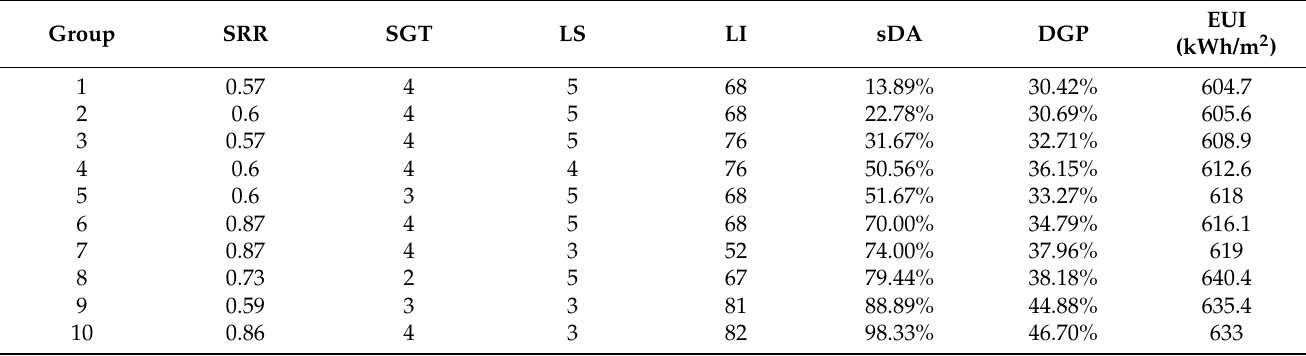
Figure 23. Pareto frontier images of louver shading commercial atrium. Table 16. Louver shading commercial atrium pareto-front solution